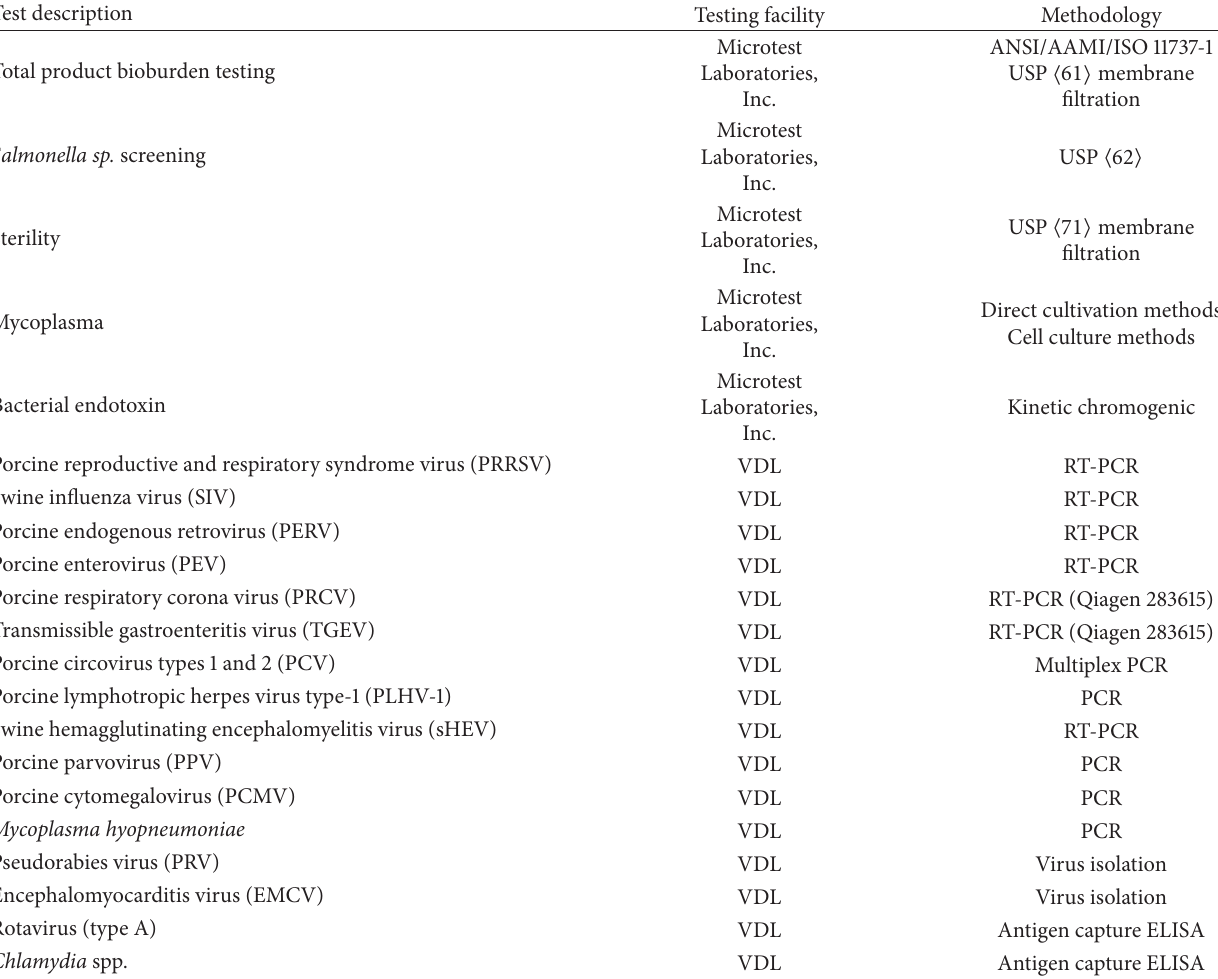
Table 1: Preimplant microbiological and vial screening of porcine islet